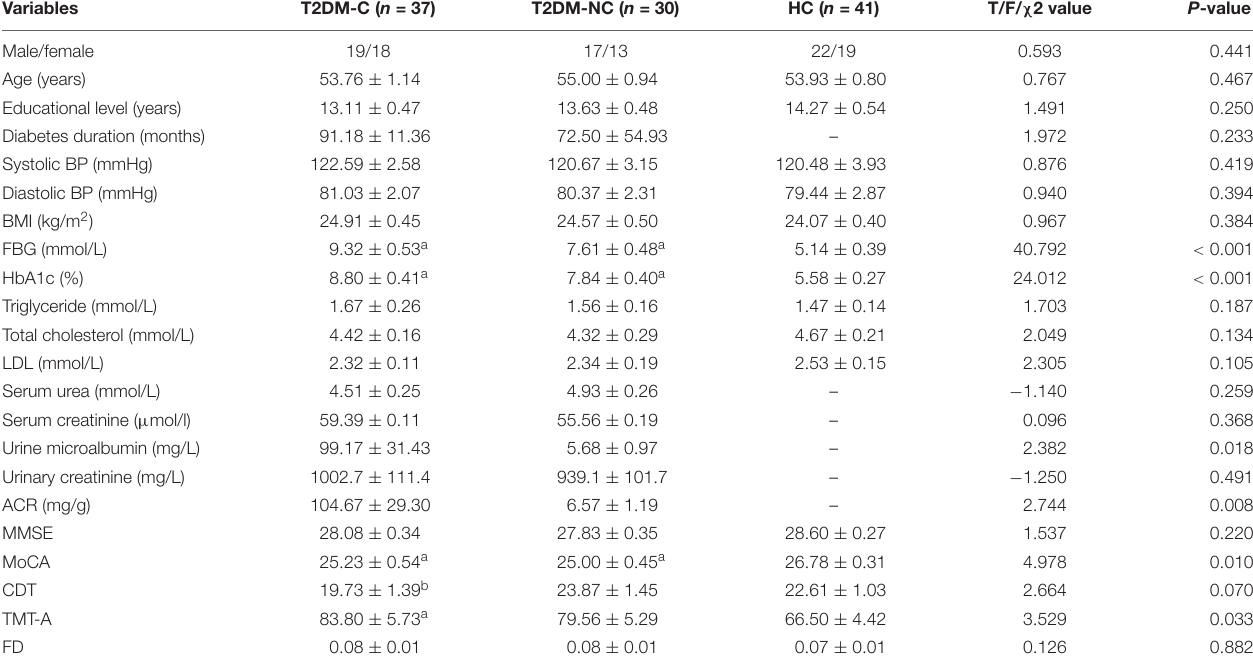
TABLE 1 | Demographic, clinical, and neuropsychological features of the subjects.